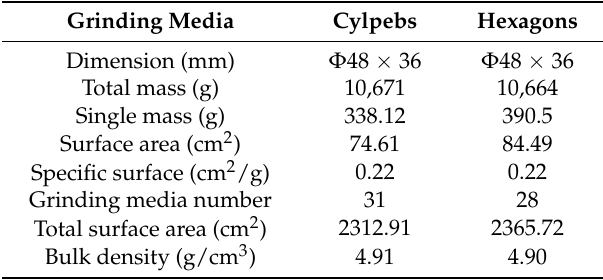
Figure 1. Photographs of grinding media: ( left ) cylpebs; ( right ) hexagons. Table 1. Physical properties of grinding media.